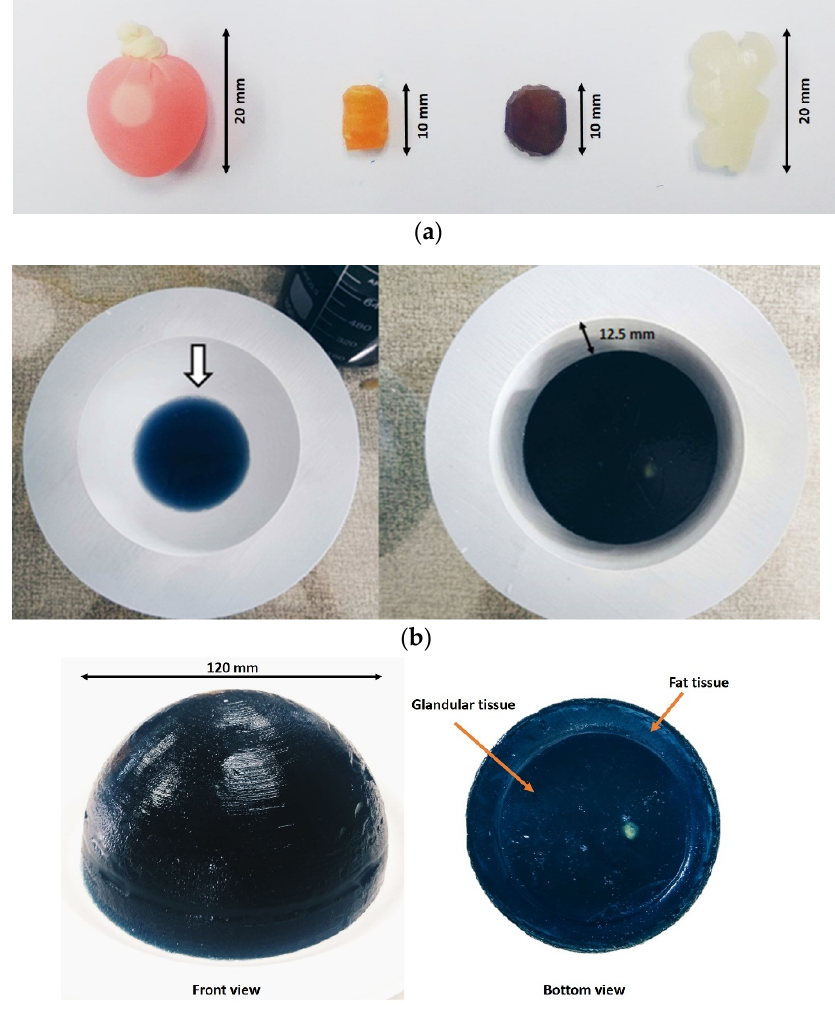
Figure 1. Three-dimensional engineering drawing of mold A). Unit: mm.